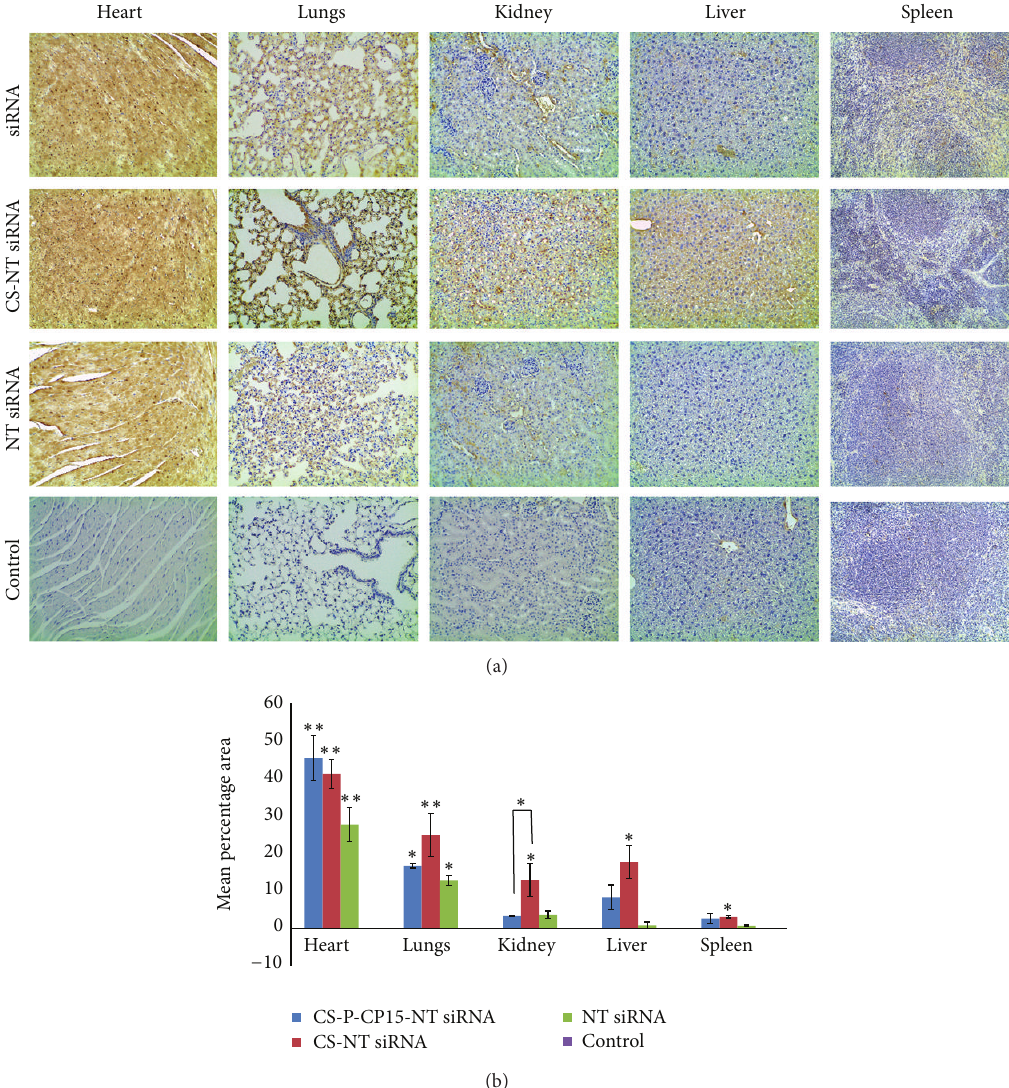
Figure 4: Analysis of biodistribution of siRNA in various tissues after 4 hours of dose administration. (a) Histopathological images of heart, lungs, kidney, liver, and spleen obtained from a mouse xenograft model of colon cancer. The represented dark brown staining in the tissues emphasizes the presence of scrambled biotinylated siRNA (0.5mg/kg) with different treatment formulations: chitosan-PEG-CP15, Unmodified chitosan nanoparticles, non-targeting biotin-siRNA alone, and control as untreated. (b) Image analysis of the mean percent area stained in the tumor tissues. The graph shows a representative result of the average of two random sections measured per animal tissue, mean ± SD. ∗ 𝑃 < 0.05 , ∗∗ 𝑃 < 0.01